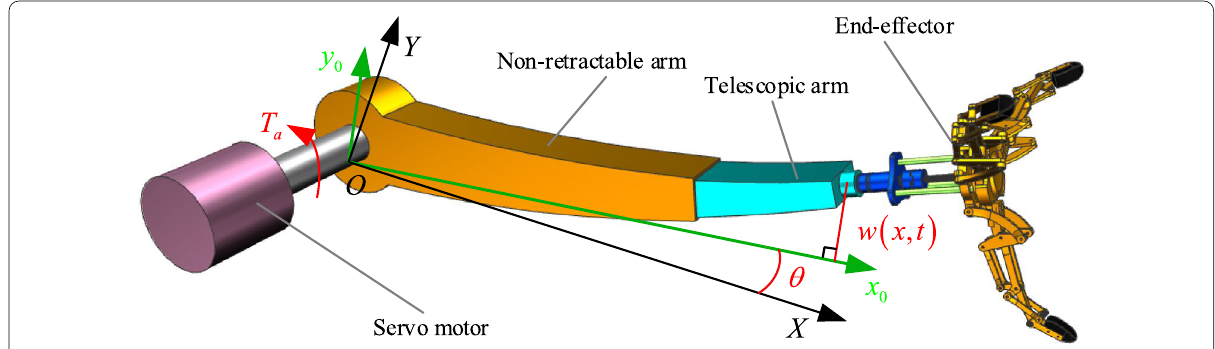
Figure 1 Schematic diagram of the telescopic flexible